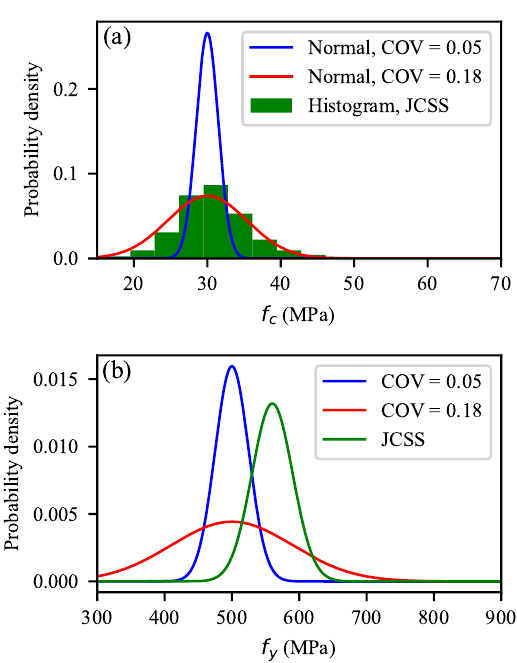
Figure 8. Statistical distributions of (a) the concrete compressive strength f c and (b) the normally distributed steel yield strength f y according to Table